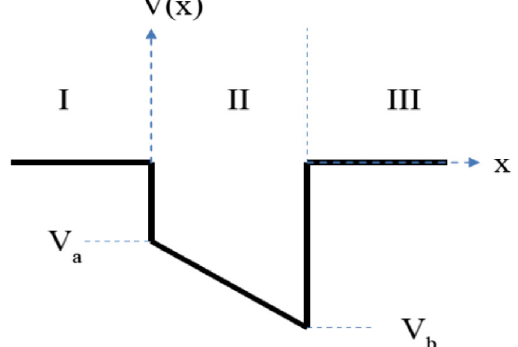
FIG. 1. Question used in this study. Part (a) was slightly different for the first cohort ’ s pretest, in which the ground state energy was not specified to be above V a . The change was made for ease of grading and did not significantly affect student